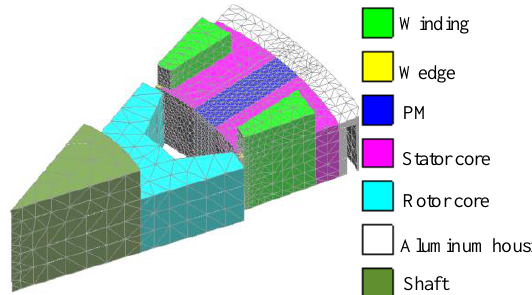
Figure 12. Asymmetric minimum element thermal (TH) field.